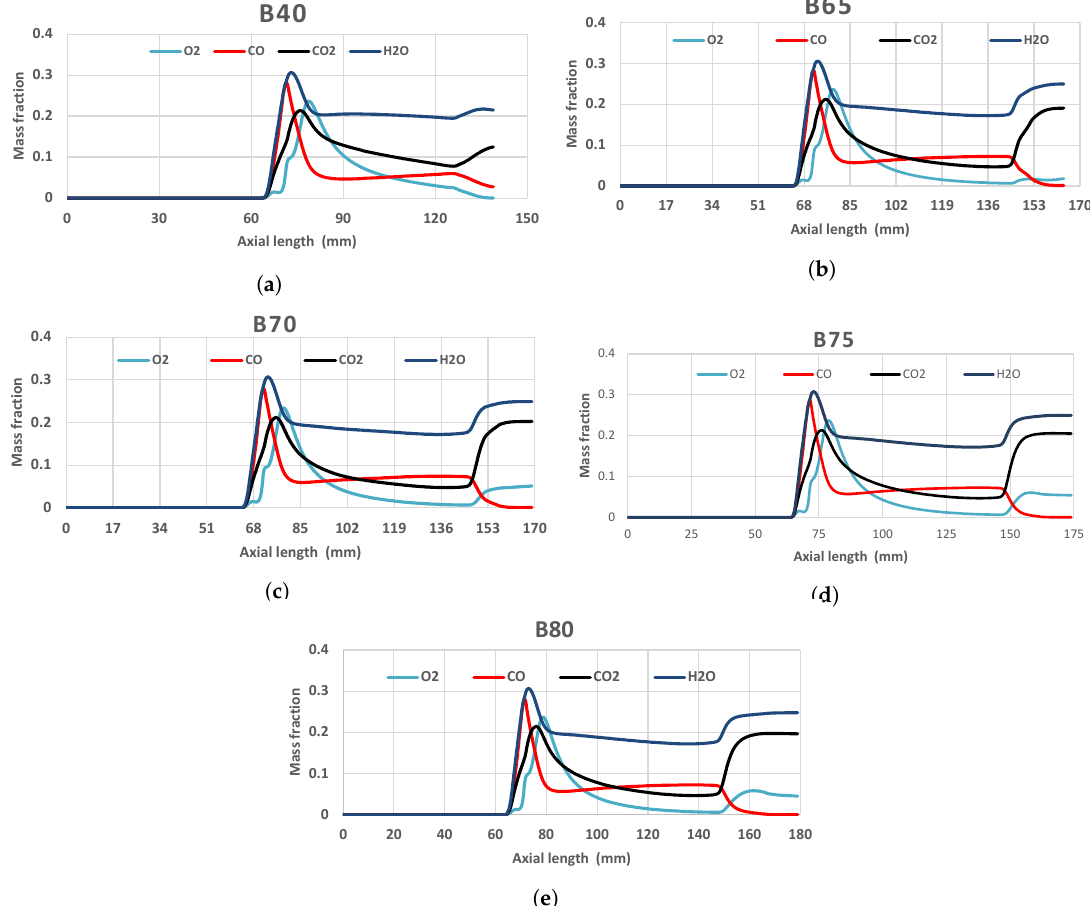
Figure 7. Variation in species mass fraction profiles with the skeletal mechanism along the x direction; the symmetry line for the evaluated ( a ) 40, ( b ) 65, ( c ) 70, ( d ) 75, and ( e ) 80 mm